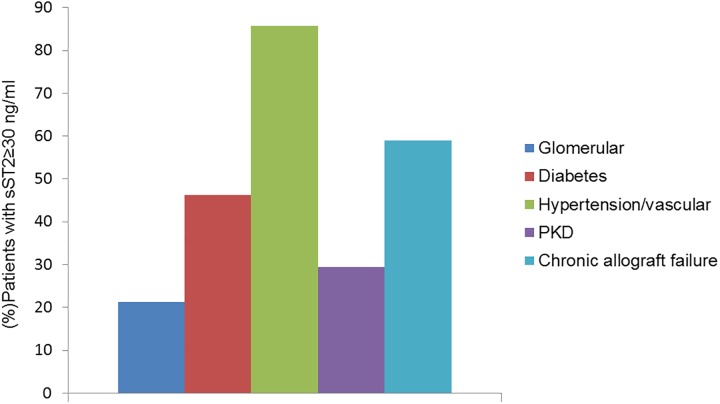
Distribution of patients with an elevated sST2 level across different causes of ESRD.sST2 level was higher in patients with ESRD secondary to hypertension, renovascular disease and chronic allograft failure compared to other causes.